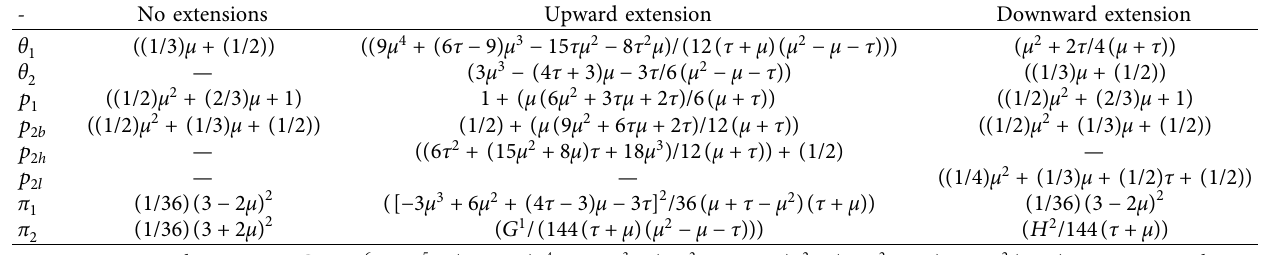
Table 1: Equilibrium outcomes when the low-quality firm expands the product line.